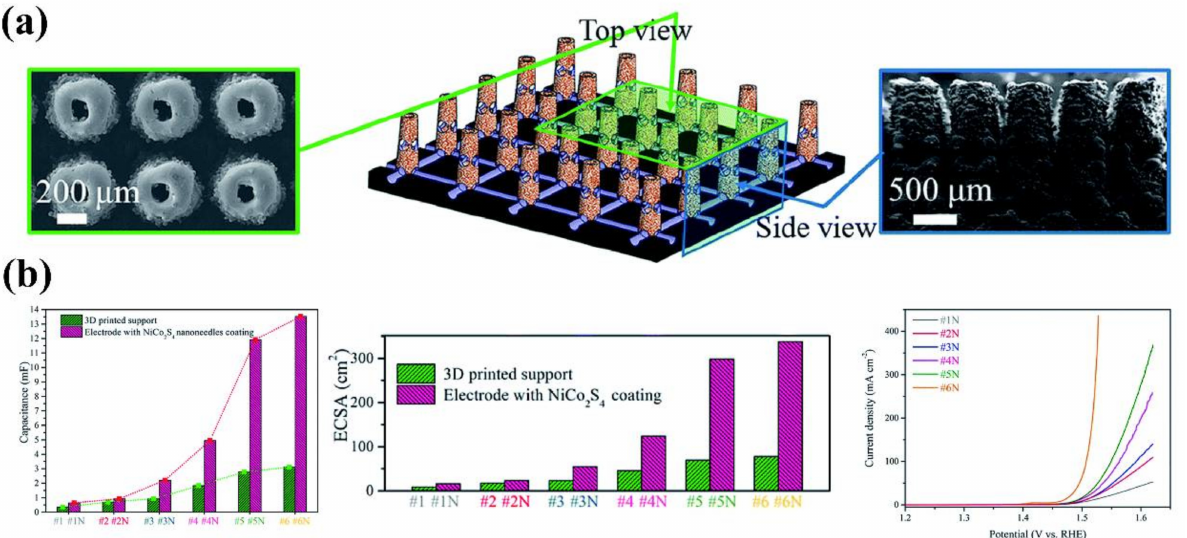
Figure 4. ( a ) Images of 3D stainless steel supported NiCo 2 S 4 nanoneedles ( b ) and the electrochemical performance [57]. Reproduced with permission from ref. (Chang, 2019) Copyright, 2019, Royal Society of